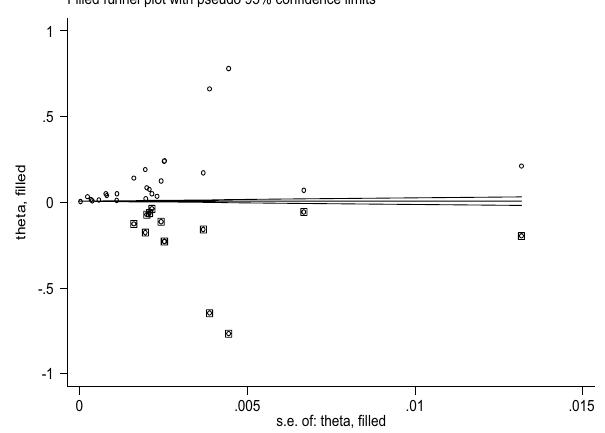
Figure 9. Trim and fill analysis of funnel plot to trim publication bias among studies,